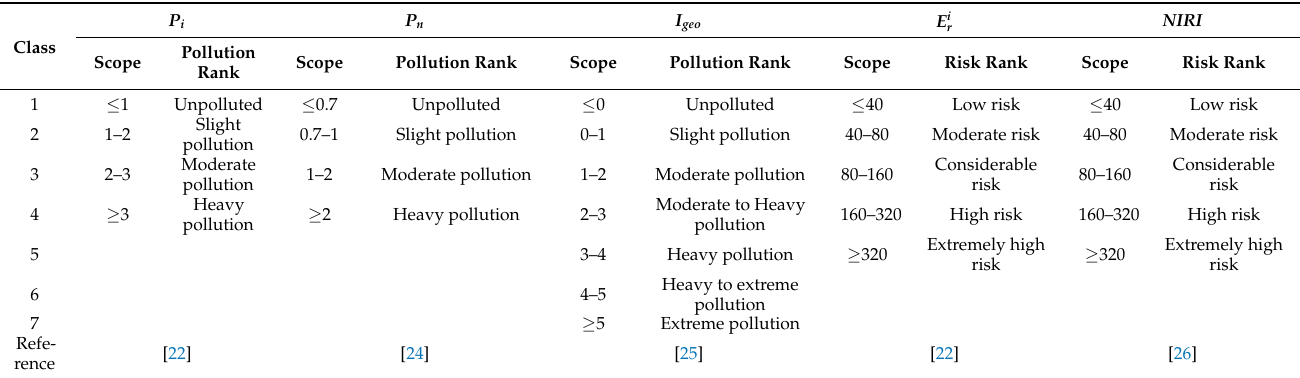
Table 1. Classifications of heavy metal pollution and risk rank of P i , P n , I geo , E i r , and NIRI